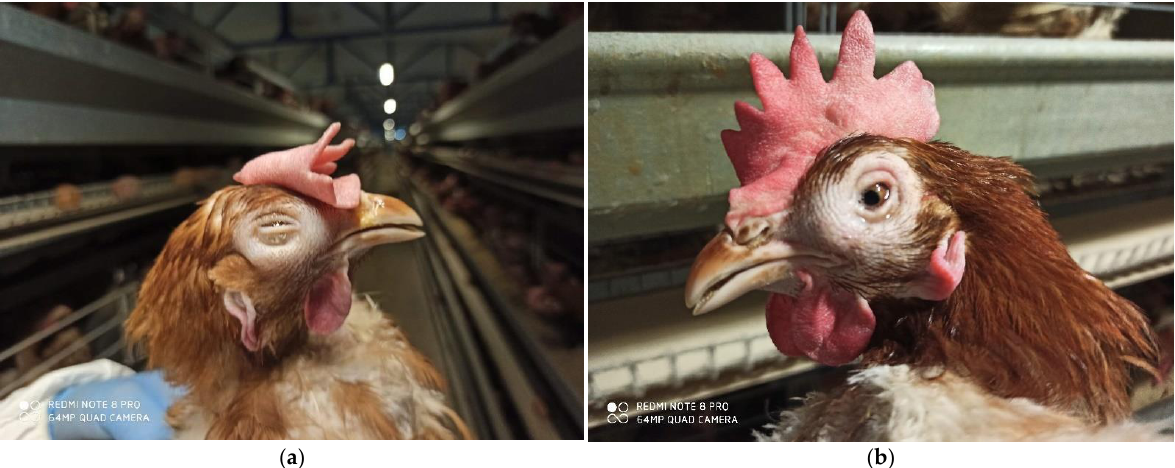
Figure 2. ( a , b ) Diseased hens with clinical symptoms — bilateral swelling of the head, runny nose, conjunctivitis, increased tearing.